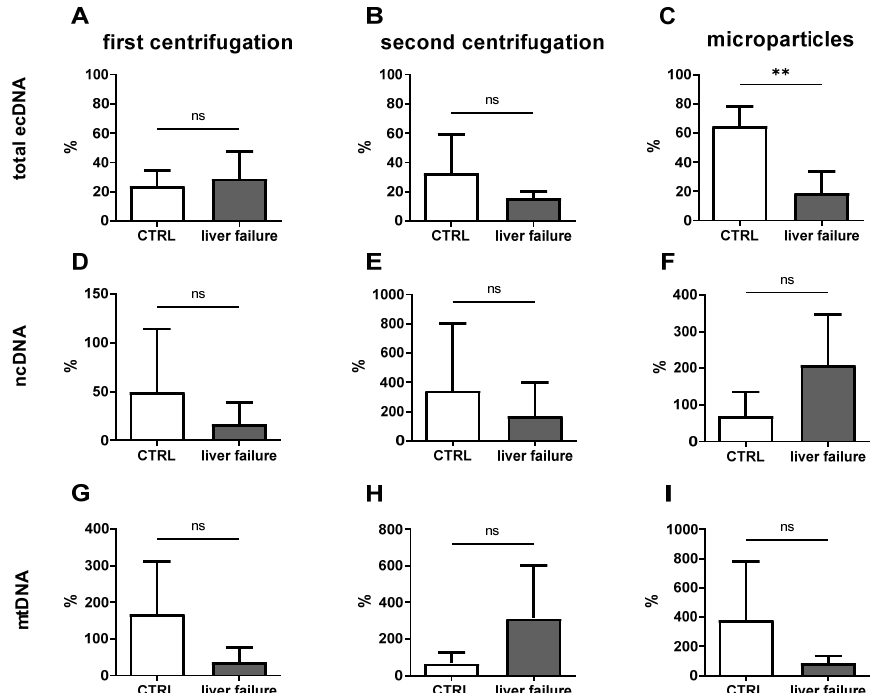
Figure 2. The proportion of protected ecDNA in acute liver failure in comparison to the control group in the fraction after centrifugation at ( A ) 1600 × g , ( B ) 16,000 × g , and ( C ) in the microparticles. The percentage of protected ncDNA was determined for all fractions, including plasma centrifuged at ( D ) 1600 × g , ( E ) 16,000 × g , and ( F ) the microparticles. The same was measured for the mtDNA from plasma centrifuged at ( G ) 1600 × g , ( H ) 16,000 × g , and ( I ) the microparticles. Data are presented as a mean with standard deviation. **— t -test with p < 0.01, ns—non-significant. Variability in protected ecDNA was especially high in the mtDNA fraction. In many cases, the percentage of protected mtDNA was higher than 100%. The percentage of protected mtDNA in plasma centrifuged once was 36% in the control group. The percentage of protected mtDNA in acute liver failure was 36% (Figure 2G; t -test; p = n.s.). Plasma centrifuged twice contained 39% of protected mtDNA in the control group and more than 100% in acute liver failure (Figure 2H; t -test; p = n.s.). On the other hand, the percentage of protected mtDNA in the microparticles was more than 100% in the control group, but 88% in acute liver failure (Figure 2I; t -test; p = n.s.). Fragmentation analysis of the